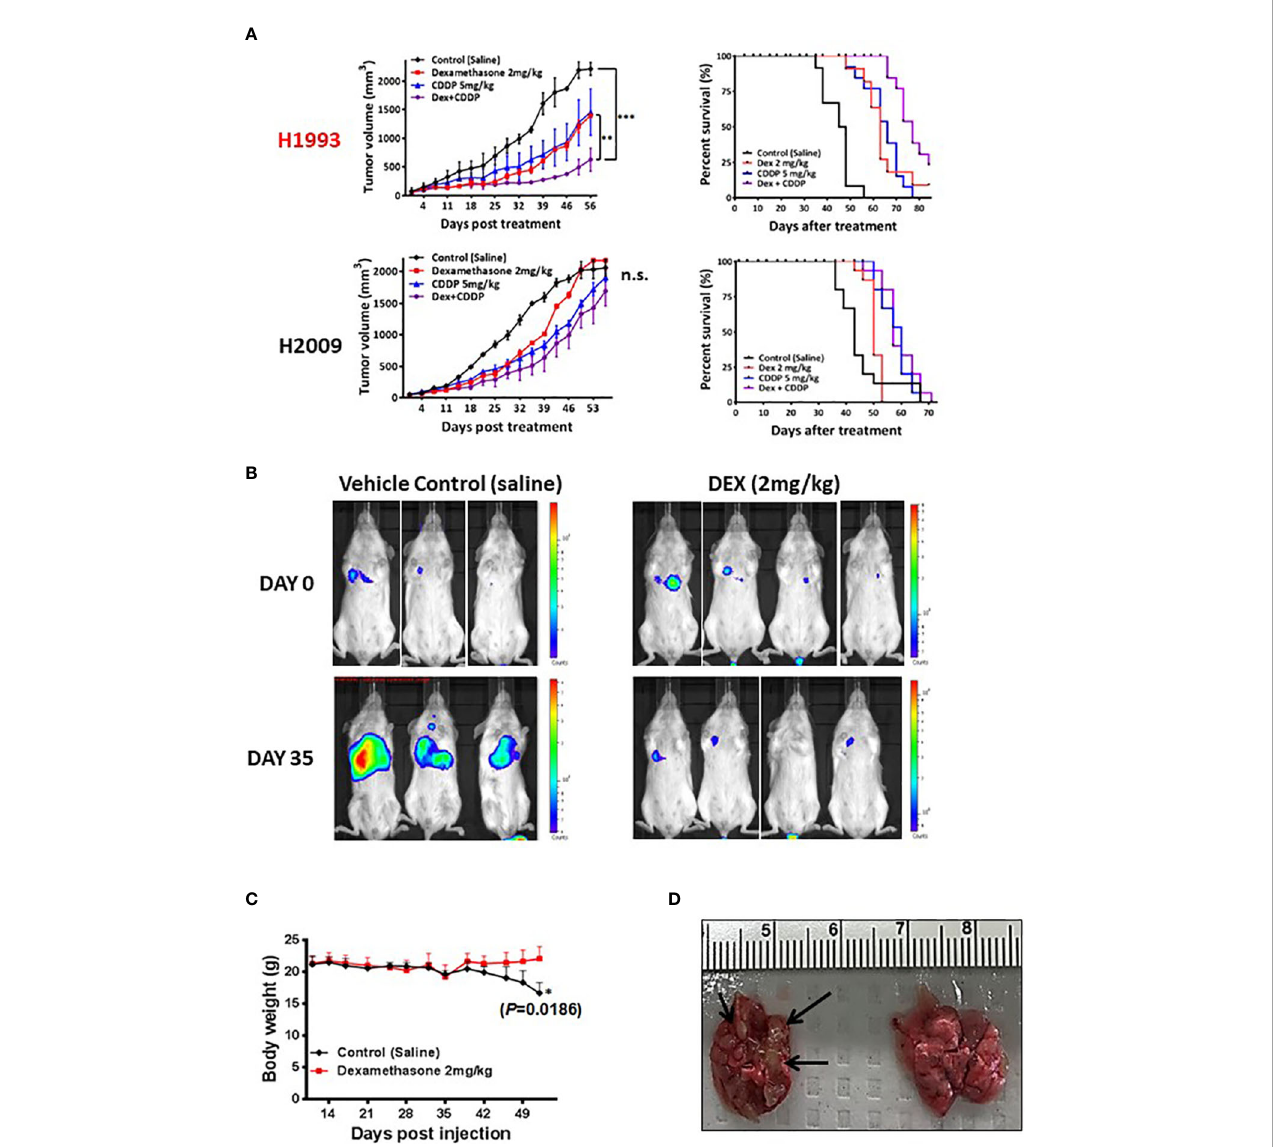
FIGURE 3 In vivo xenograft and orthotopic model studies show DEX mediated inhibition of tumor growth. (A) NSCLC cell line xenograft studies using DEX sensitive cell line (NCI-H1993 in red) and resistant cell line (NCI-H2009). Once tumors for each cell line reach an average size of 150 mm3, they are randomized and split into four treatment groups (1); vehicle control (2), DEX only (3), cisplatin only and (4) DEX + cisplatin. Treatments are stopped after four weeks and tumors allowed to progress until they reach ~2000 mm3 at which point mice are sacri fi ced. DEX and platinum as single agents show similar anti- tumor responses and survival bene fi t (red, blue line respectively). The combination DEX + cisplatin treated groups performed best in sensitive NCI-H1993 (purple line). No signi fi cant response was observed in DEX resistant NCI-H2009. (B) Mouse orthotopic model created by tail vein injection of luciferase labeled A549 cells into 20 mice. After three weeks, 7 mice showed similarly sized tumors as judged by BLI. Mice were randomized and split into two groups (1); vehicle control and (2) DEX treated. The fi rst BLI images shown were taken before fi rst day of DEX or vehicle treatment. The second set of images was taken 35 days after the start of treatment. (C) Body mass of DEX treated (red line) and vehicle control (black line) during progression of experiment. (D) Example of lungs removed after sacri fi ce for DEX treated (right) and control (left). Black arrows point to visibly signi fi cant tumor nodules in vehicle